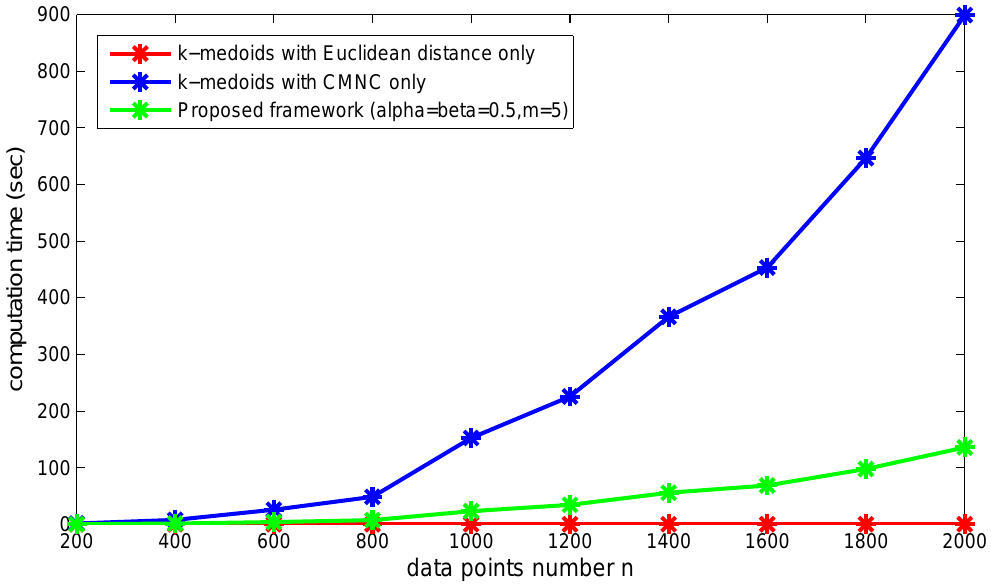
Figure 24. Increase of execution time when n increases.